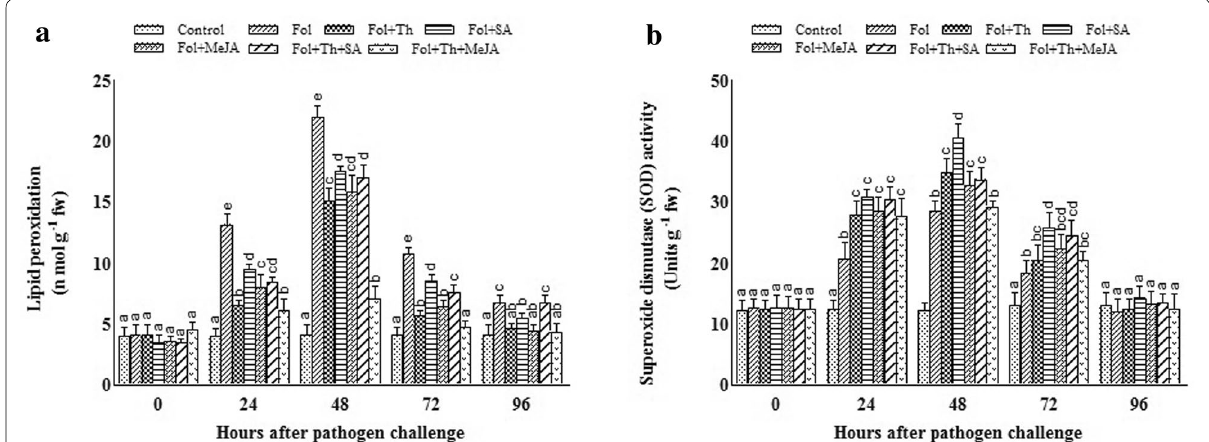
Fig. 5 Estimation of changes in the a concentration of MDA b activity of SOD, in tomato plants pre-treated with T. harzianum , SA and MeJA either individually or in combination after challenge inoculation with Fusarium oxysporum f. sp. lycopersici (Fol). Results are expressed as the mean of three replicates and vertical bars indicate SD of the mean. Different letters indicate significant differences among treatments within the results taken at the same time interval according to Duncan’s multiple range test at p ≤